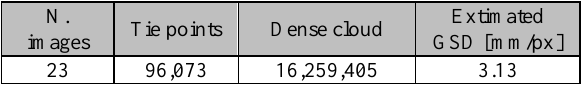
Table 2. Main details of the photogrammetric process.